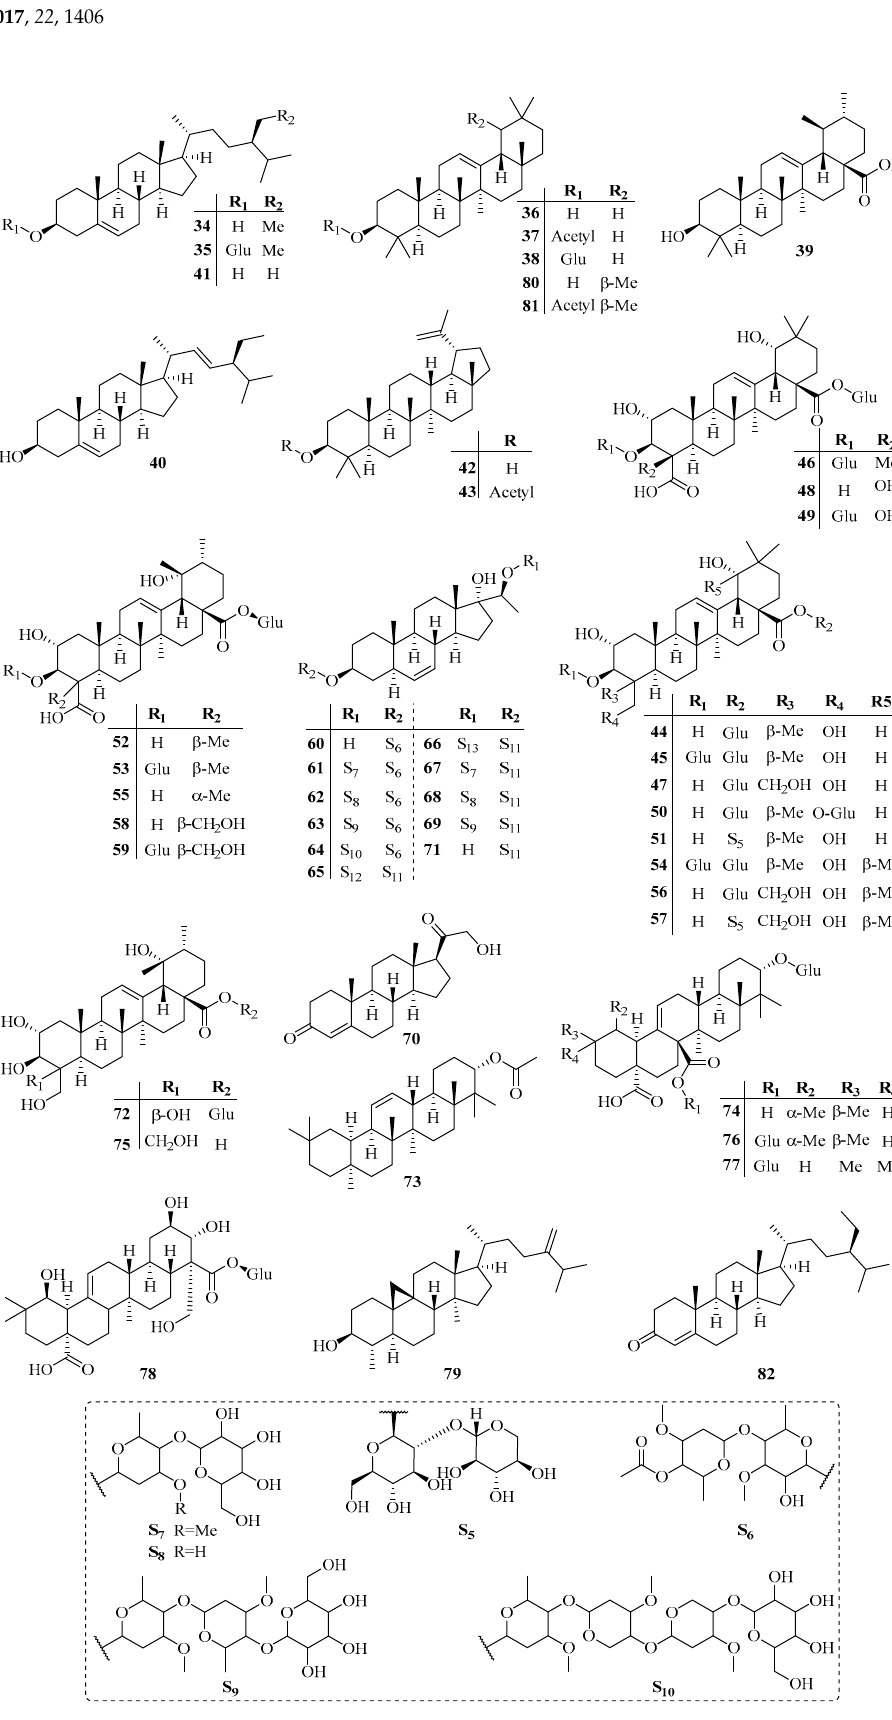
Figure 3. Triterpnoids from the Trachelospermum plants.